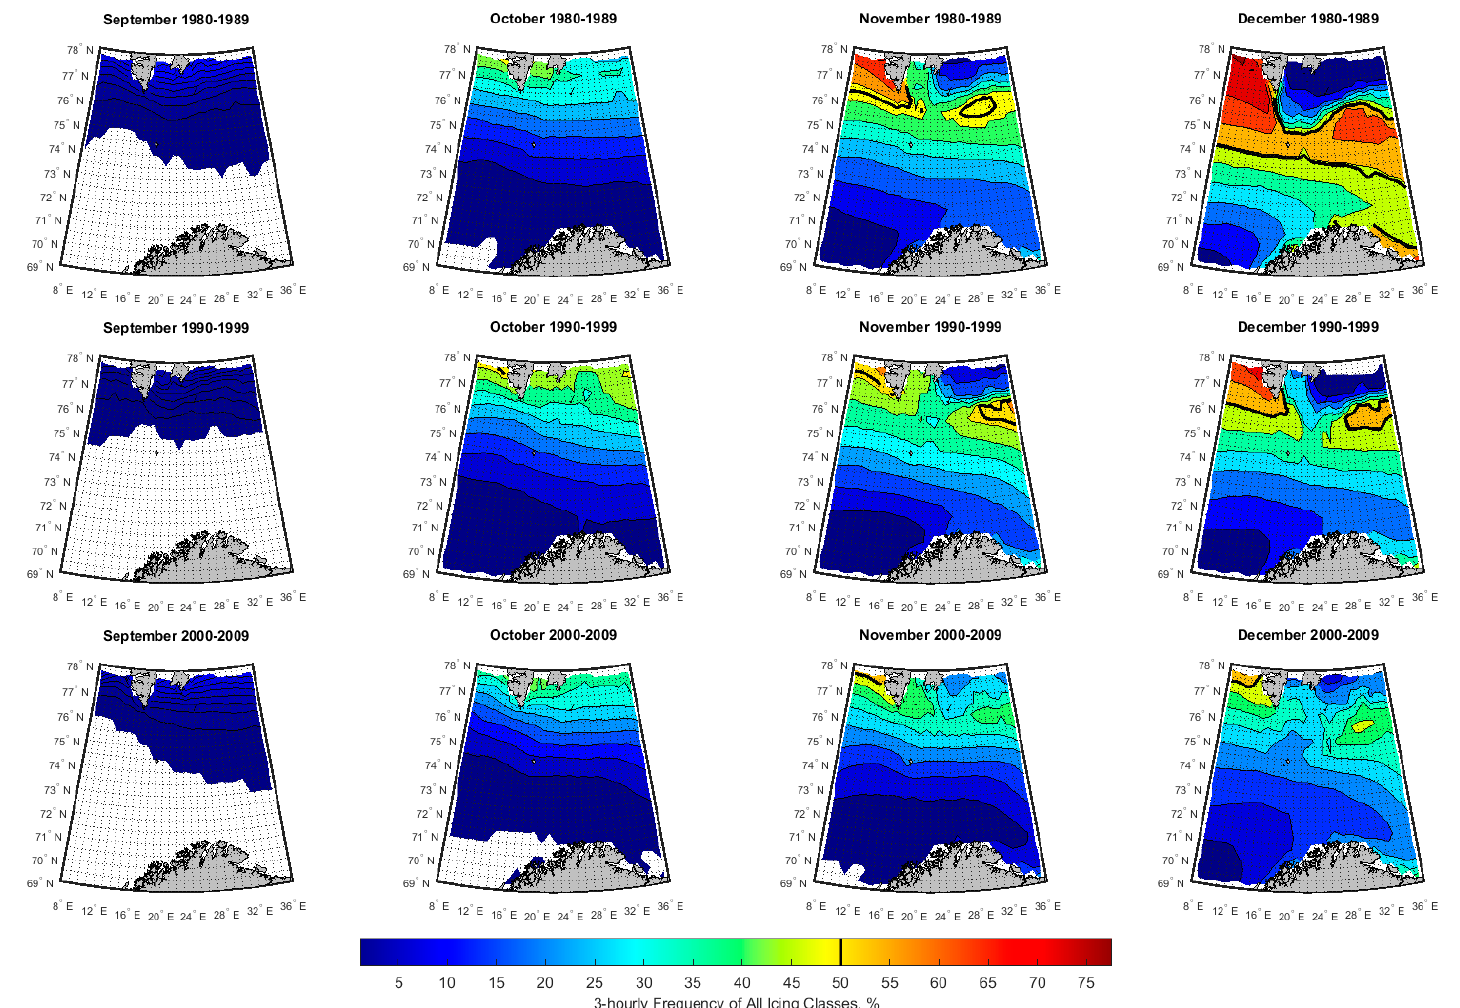
Figure 15. Three-hourly frequency of icing events (all classes) in each region during the 1980s, 1990s, and 2000s (Sep, Oct, Nov, Dec).